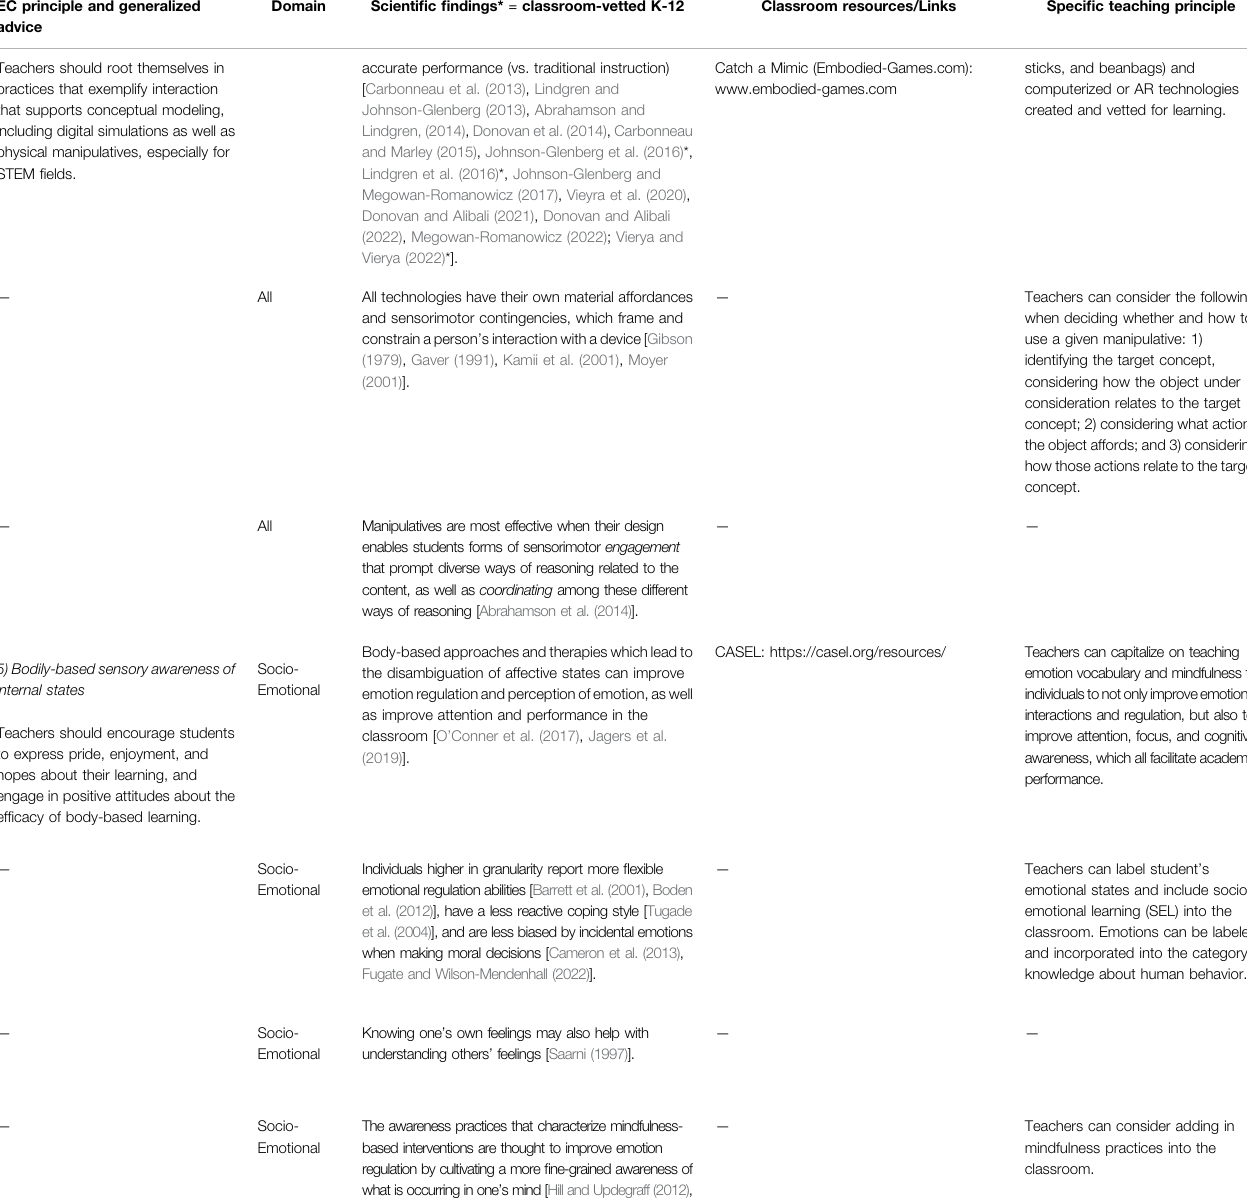
TABLE 1 | ( Continued ) Key Principles for Translational Learning Sciences Research for Embodied Cognition and Embodied Learning. EC principle and generalized